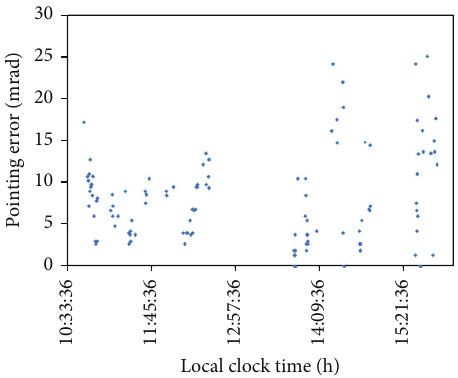
Figure 16: Measurement result of pointing error for prototype mobile sun-tracking system under stationary condition during the period from 10 am to 4 pm on 17 th May.